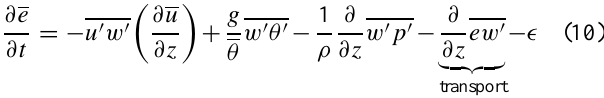
Fig. 5. Stability function for wind speed, ψ m = ln line is the best-fit curve for Eq. 21 in Cheng et al.